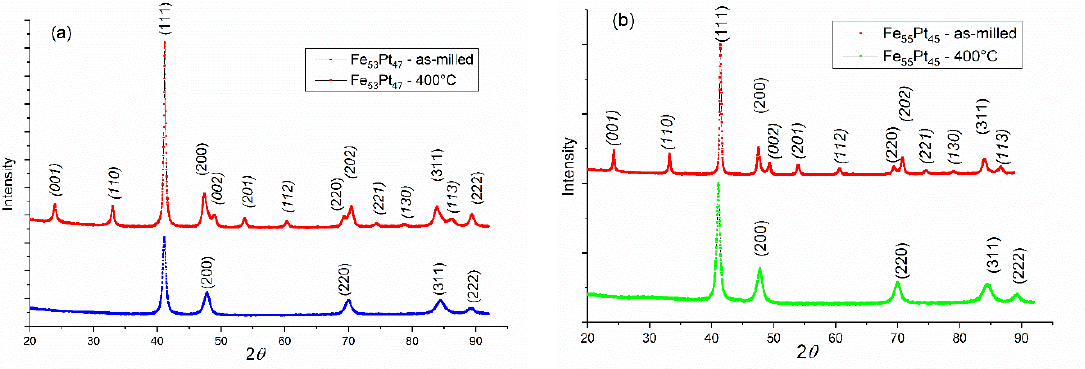
Figure 2. XRD di ff ractograms for as cast samples of ( a ) Fe 53 Pt 47 and ( b ) Fe 55 Pt 45 powders annealed at 400 ◦